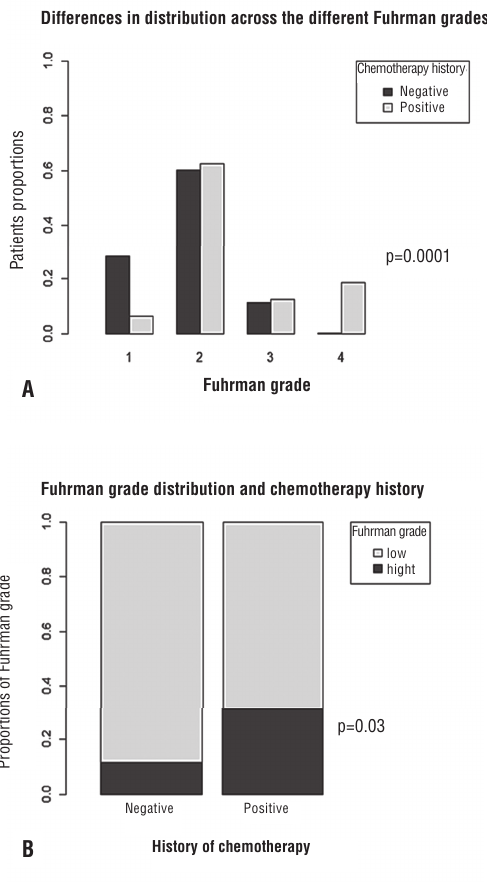
Figure 1 - The distribution of Fuhrman grade was signifi cantly different between the chemotherapy group and the general population (1a). The chemotherapy group had signifi cantly higher rates of high Fuhrman grade